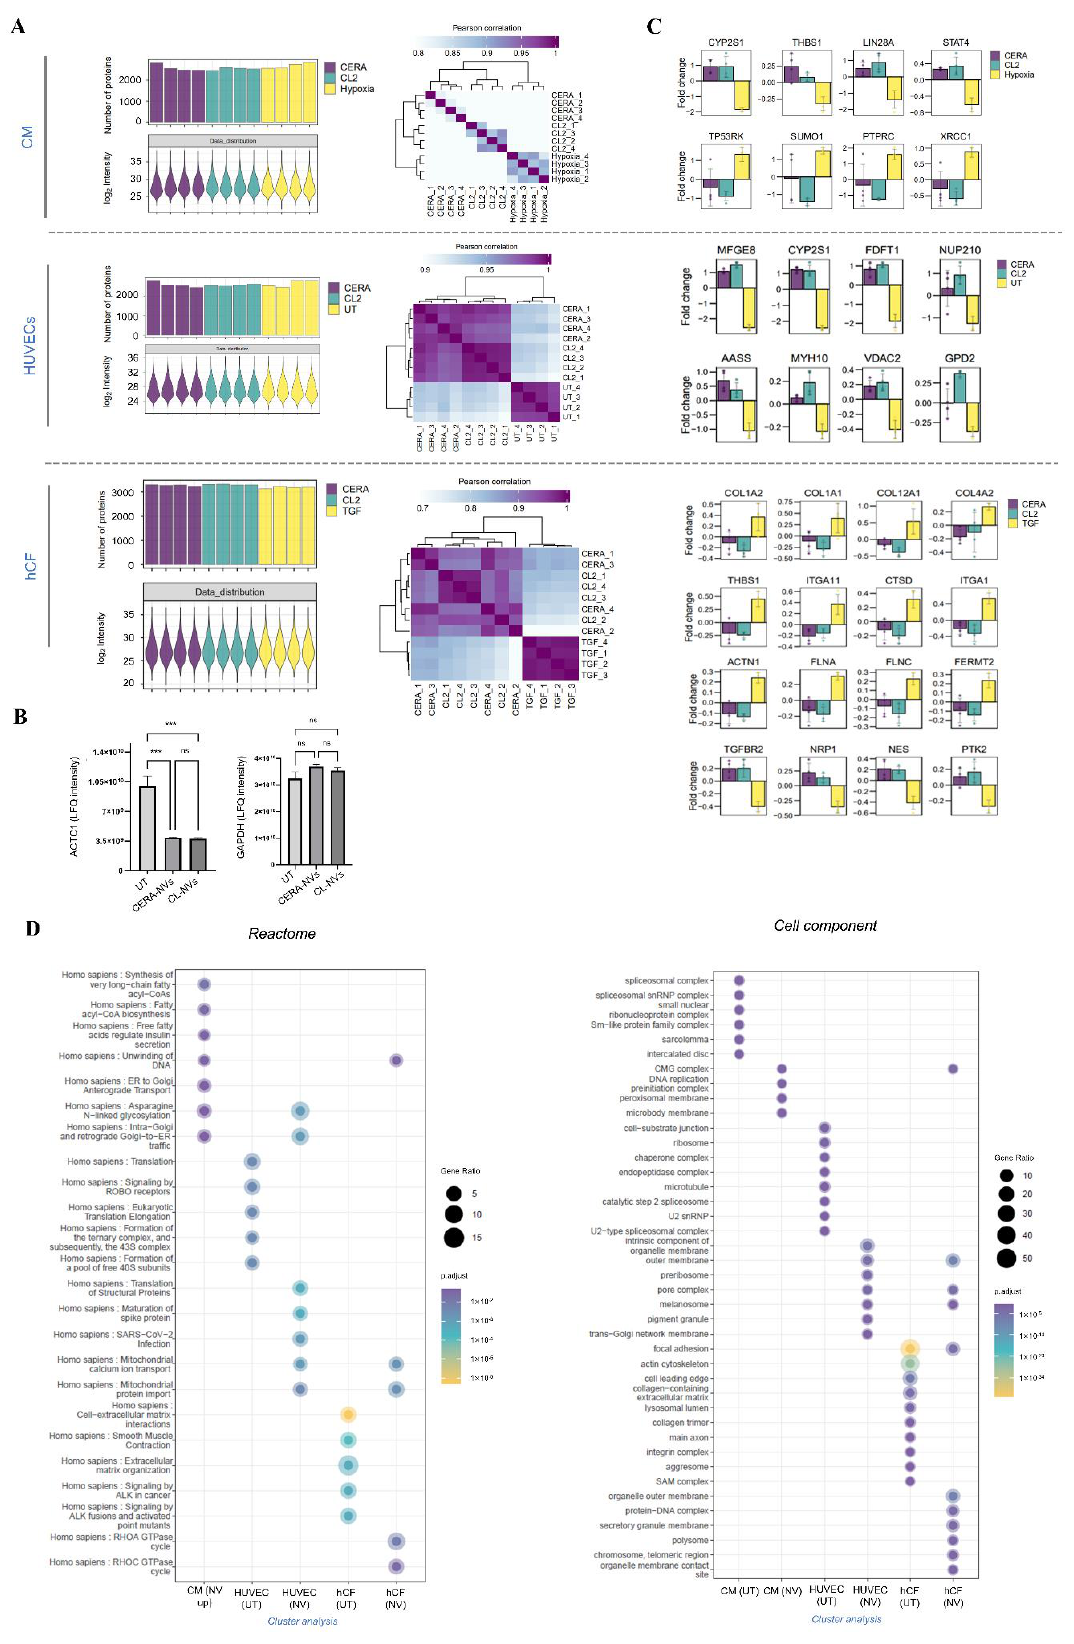
Figure 5. iPSC NVs induce target cell proteome reprogramming to support repair functions. ( A ) Cell proteome analysis of cell assays following NV treatment: cardiomyocyte (CM) survival,